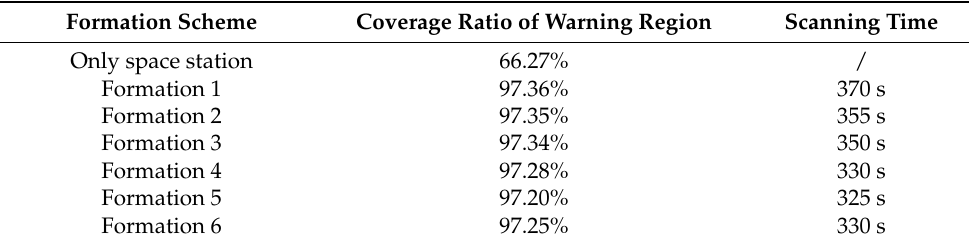
Table 2. Efficiency analysis of early-warning region